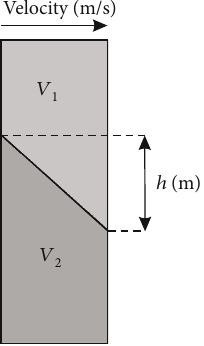
Figure 1: Simpli fi ed model of a transition zone (Wolf ramp).